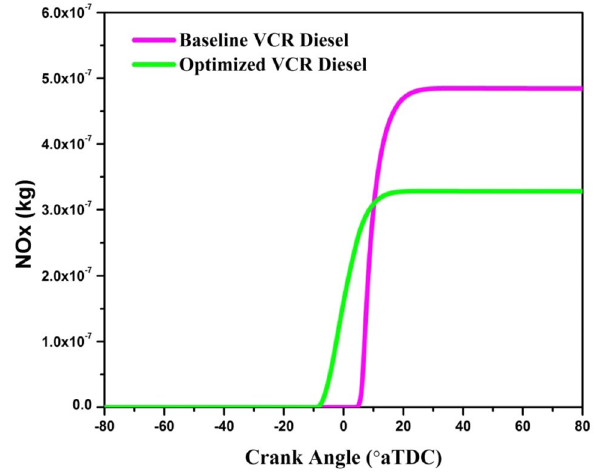
Fig. 6 Comparison of Pressure versus Crank Angle for optimized and baseline (VCR diesel)